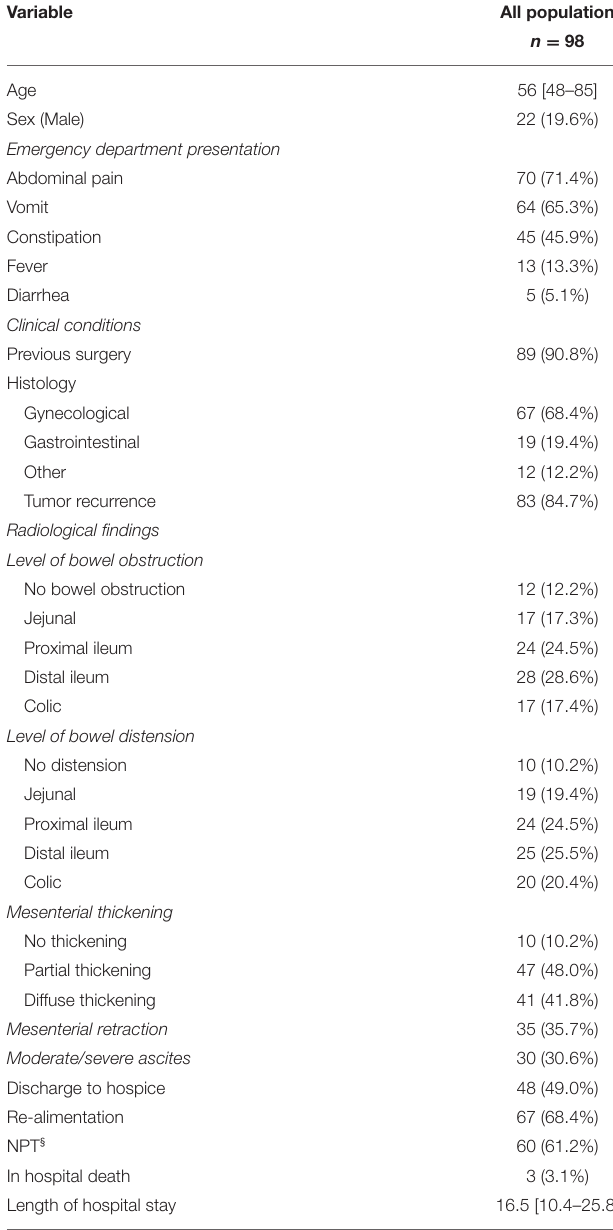
TABLE 1 | Population demographics and baseline